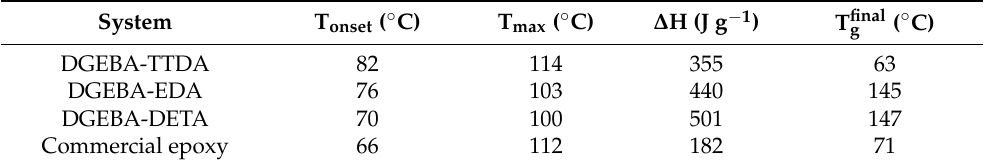
Figure 2. DSC thermograms before and after curing for DGEBA-EDA and DGEBA-DETA ( a ), DGEBA-TTDA ( b ) and commercial epoxy ( c ) under investigation. Table 1. Curing parameters of epoxy systems.